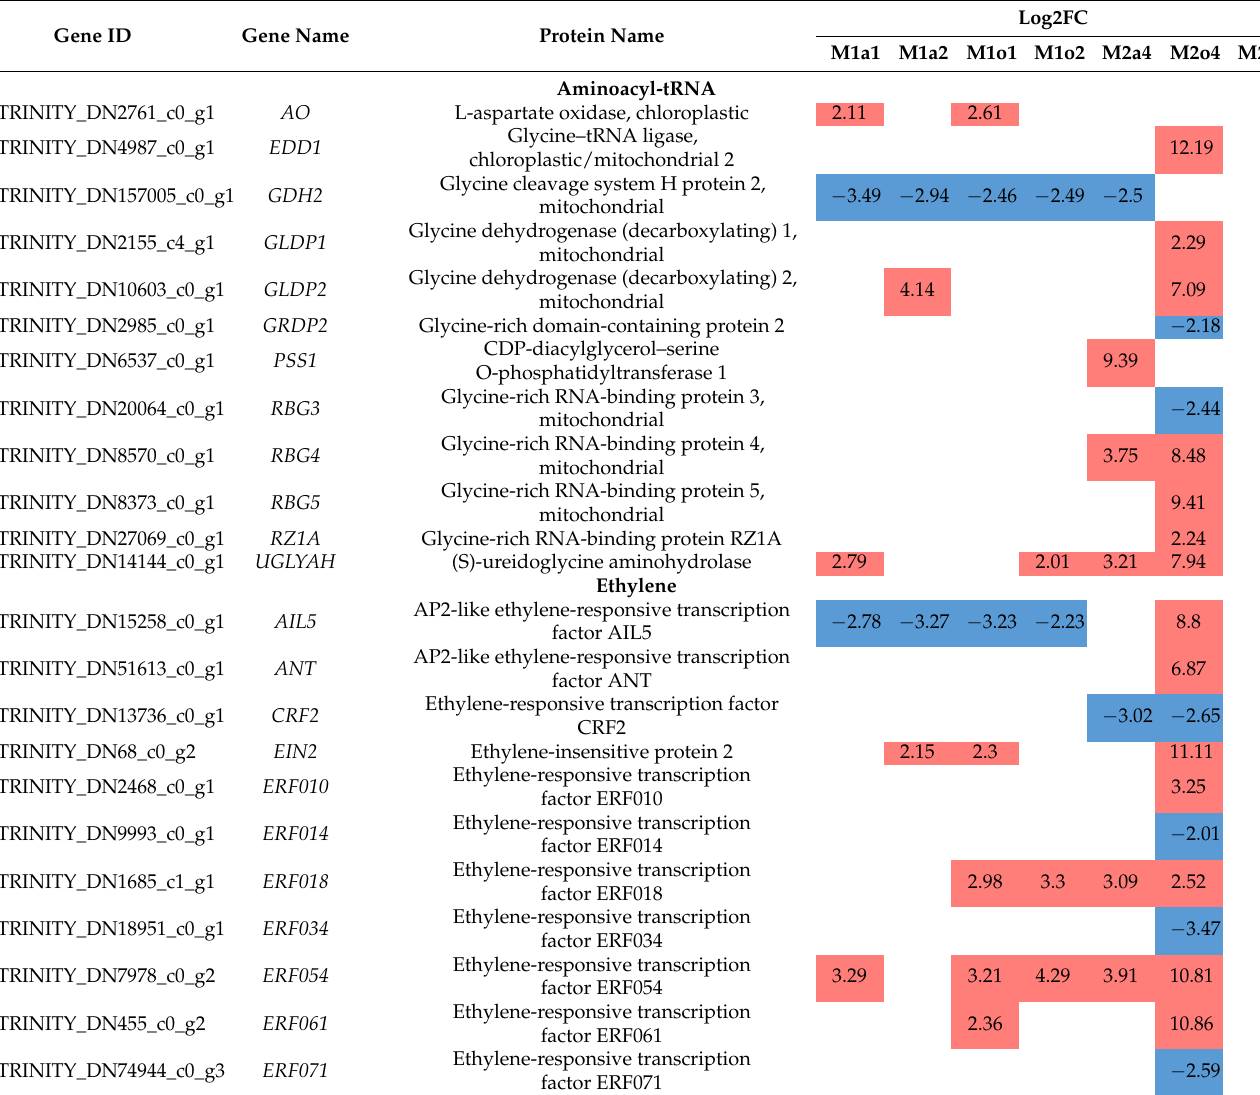
Table 5. List of differentially expressed genes (DEGs) in ovules of Limonium plants, namely apomictic L. multiflorum (M) relative to sexual L. auriculifolium (a) and L. ovalifolium (o), in different stages, which are involved in tryptophan, ethylene, aminoacyl-tRNA, or lysine metabolism. DEGs were filtered by |log2 fold-change (log2FC)| > 2. DEGs were mapped to their respective A. thaliana homolog (gene name) and annotated according to its reference genome (red: up-regulated DEGs; blue: down-regulated